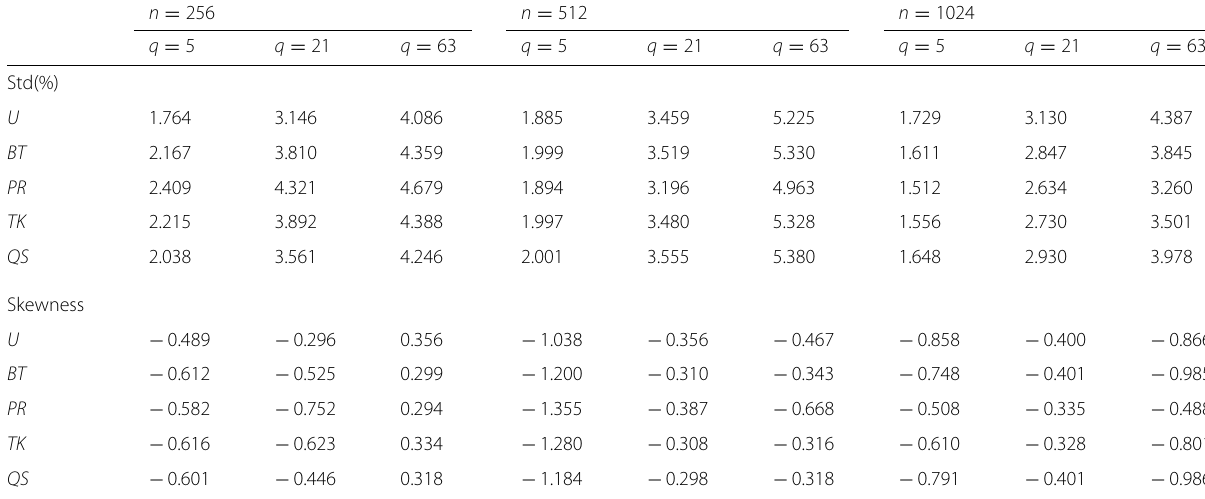
Table 2 Comparison of unbiased overlapping return standard deviation and skewness estimators as a function of weighting scheme, sample size n , and overlapping return period q